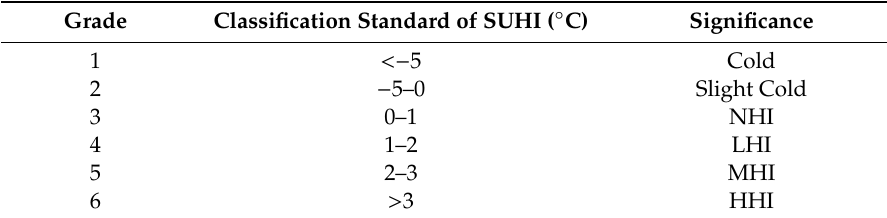
Table 2. Standard grades of surface urban heat island